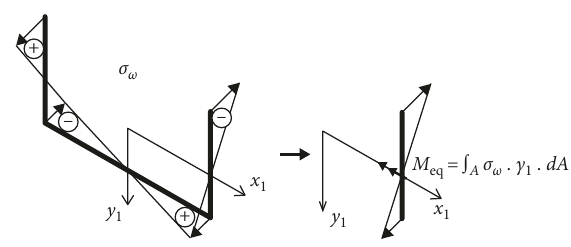
Figure 3: Distributing method for warping